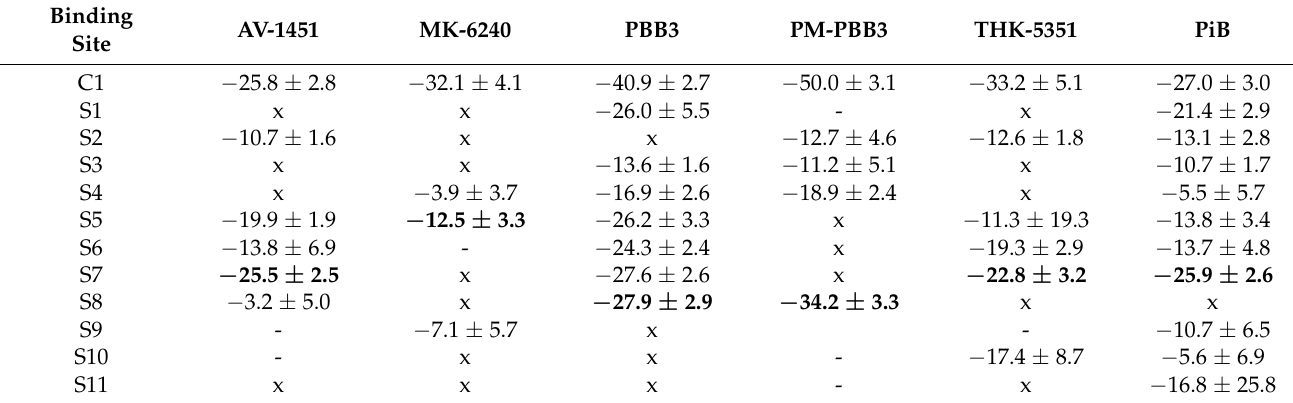
Table 2. The calculated MM/GBSA binding energies (kcal · mol − 1 ) of PET probes in Tau PiD binding sites. The label “x” represents sites where PET probe was not docked and a label “-” shows cases where MM/GBSA binding energies could not be calculated to due to tracer drift or steric clashes in certain snapshots. All the energy values are reported in kcal · mol − 1